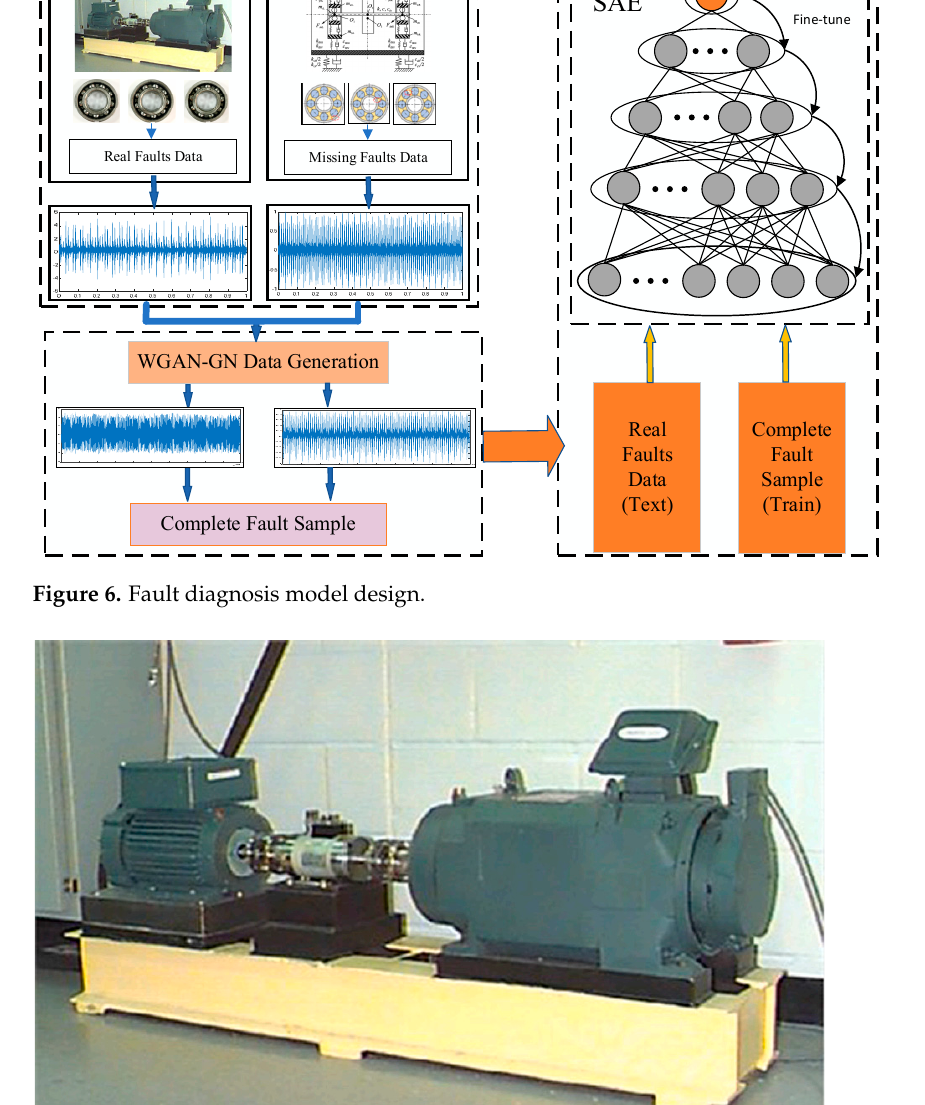
Figure 7. Rotating machinery fault diagnosis experimental device.